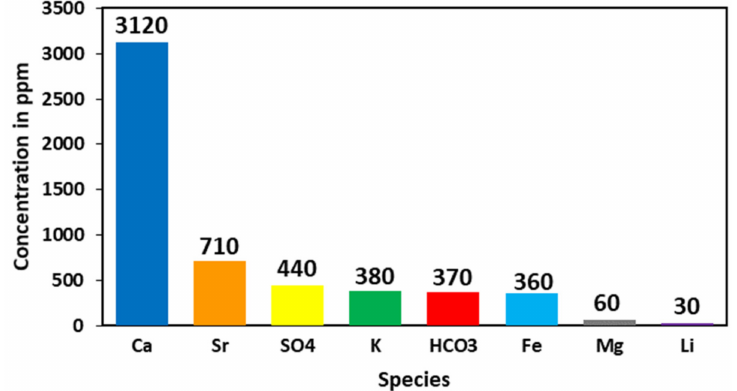
Figure 3. Ionic composition of 70 Permian Wells.